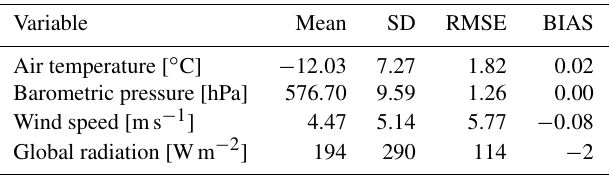
Table 4. Summary statistics of the CM weather series processing. The mean and standard deviation (SD) are computed on the fi- nal hourly series used as model input. The root-mean-square error (RMSE) and mean signed deviation (BIAS) refer to the compari- son between the reconstructed series and the quality-checked hourly measurements (Sect. 2.1).